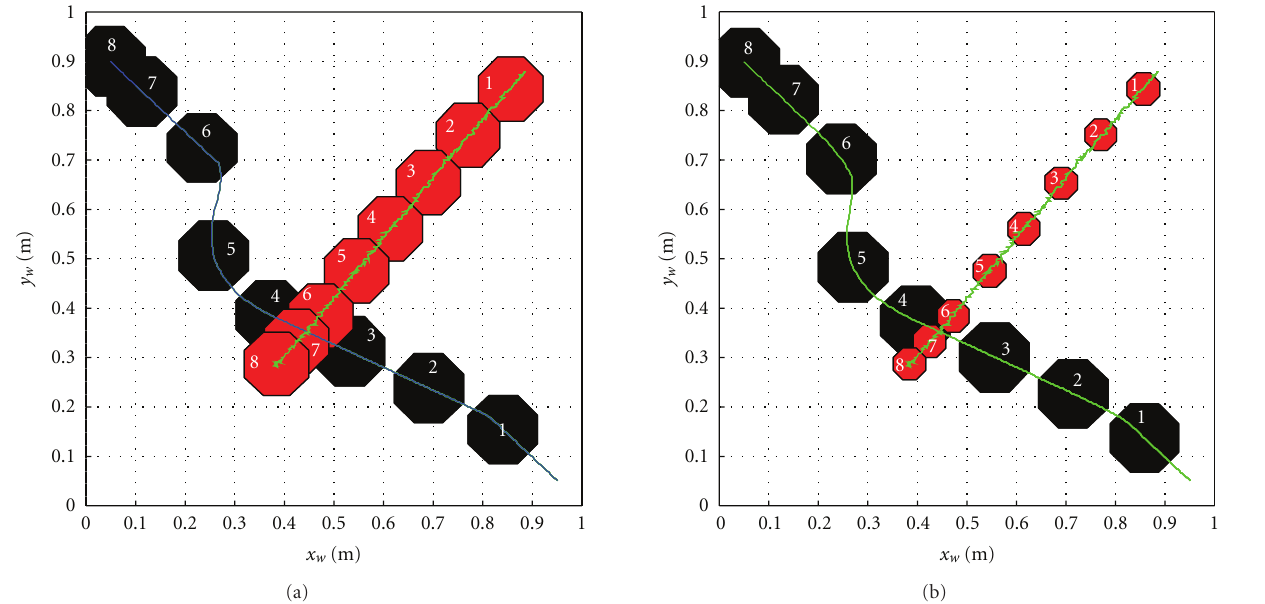
Figure 17: (a) Simulated moving obstacle avoidance. (b) Experimental moving obstacle avoidance.